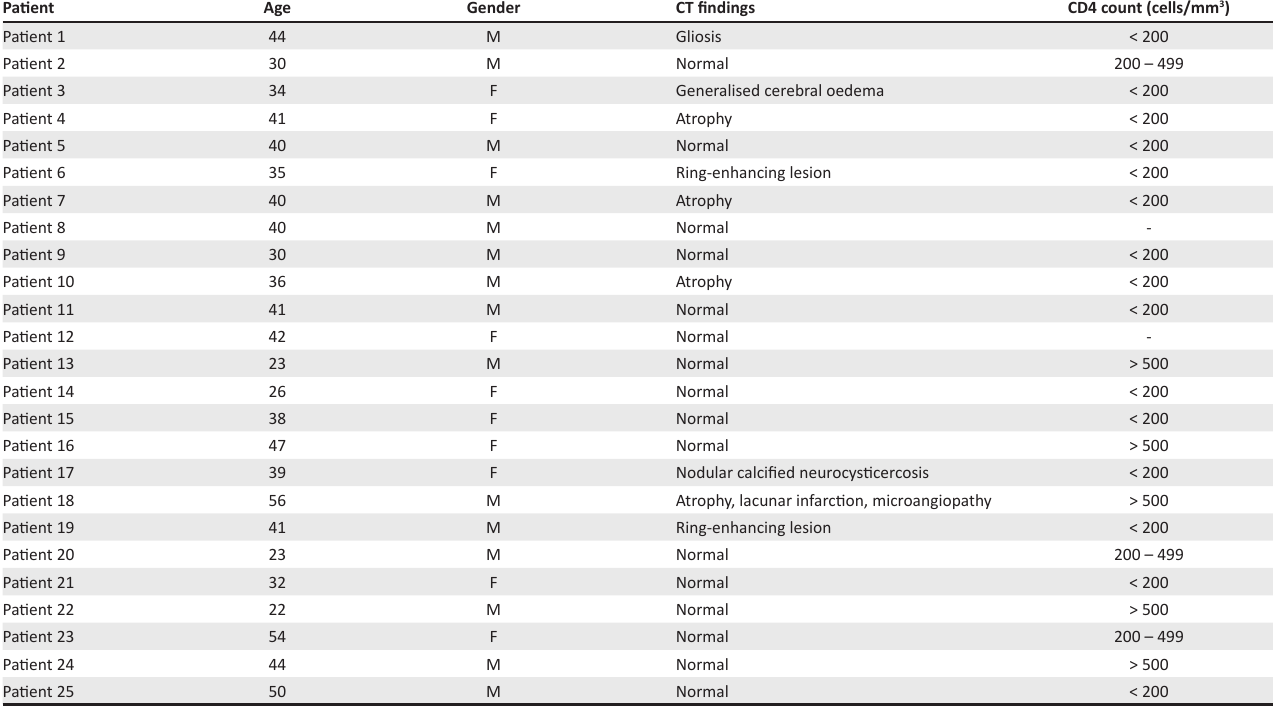
TABLE 1: Summary of the findings in our study